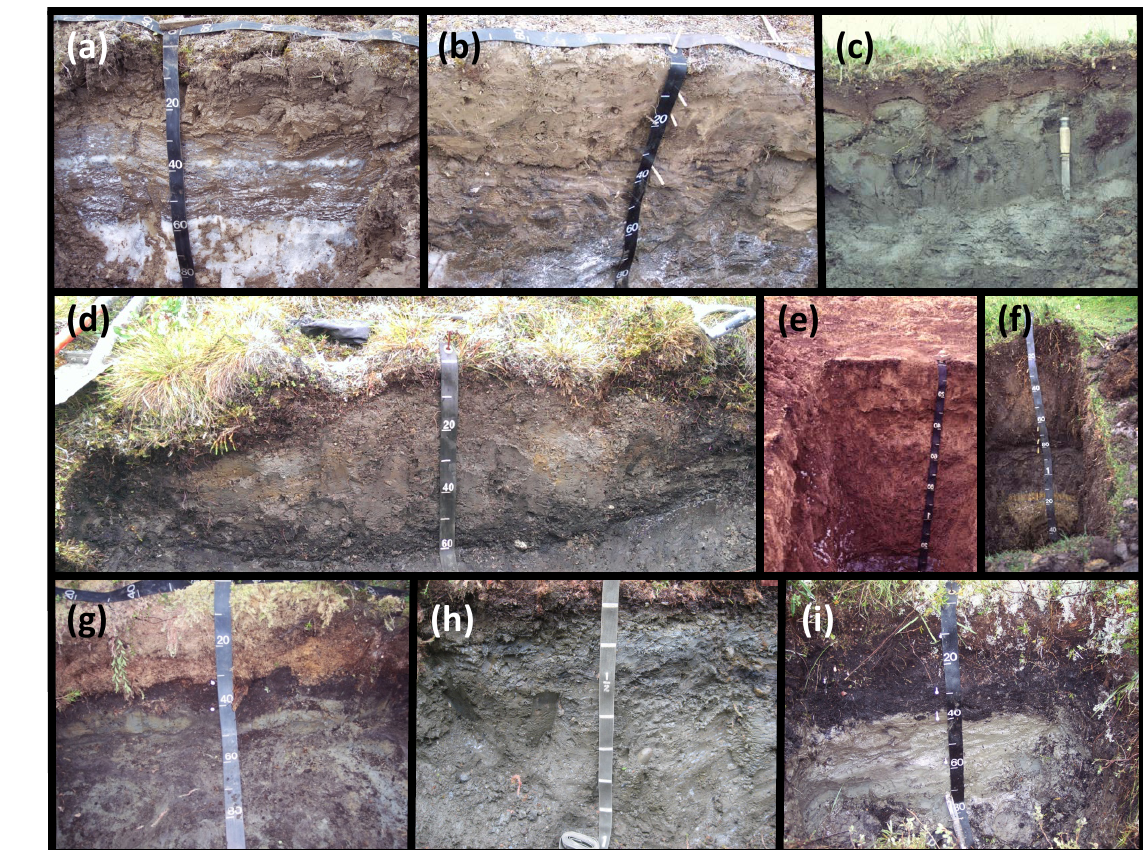
Figure 3. Examples of permafrost-affected soils from different areas: (a) Glacic Aquiturbel formed in weathered shale with small patterned ground features (polar desert), ice wedge at 58cm, Ellef Ringes Island, Nunavut, Arctic Canada; (b) Haploturbel associated with a nonsorted circle, formed in weathered siltstone (High Arctic), Mould Bay, Arctic Canada; (c) Ruptic–Histic Aquiturbel formed in Yedoma deposit under nonacidic tundra, Mys Chukochi, Northern Yakutia, Russia; (d) Ruptic Histoturbel associated with a nonsorted circle, formed in loess over Tertiary glaciofluvial deposit under tussock tundra, Arctic Alaska; (e) a well-drained Haploturbel formed in weathered sandstone under alpine tundra, northern–central Qinghai–Tibet Plateau, China; (f) Histel formed in wet Kobrecia meadow (note the limnic layer at 112cm), Qinghai–Tibet Plateau, China; (g) Histoturbel formed in late Pleistocene glaciofluvial deposit under boreal forest, northern Alaska; (h) Aquorthel formed in loess deposit under boreal forest, central Alaska; and (i) Histel formed in bog, central Alaska. Soils shown in (a) , (b) , (f) , (h) , and (i) are formed in epigenetic permafrost and soils shown in (c) , (d) , (e) , and (g) are formed in syngenetic